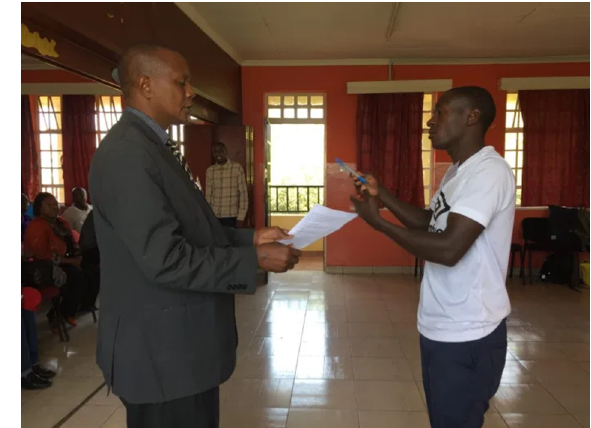
Fig. 10 A policy maker from a local ward (left) takes on the role of a factory worker and attempts to negotiate a better employment contract with the factory owner (right) through legislative theatre. Soon this ‘ factory worker ’ was forcibly removed by factory security due to insubordination and the problem remained unresolved.